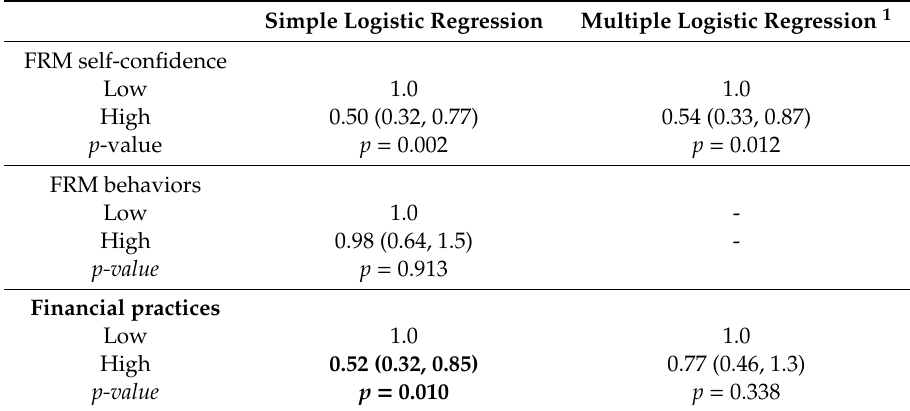
Table 4. Simple and multiple logistic regression analyses of food resource management (FRM) self-confidence, FRM behaviors, and financial practices of Head Start caregivers with household food insecurity ( n =